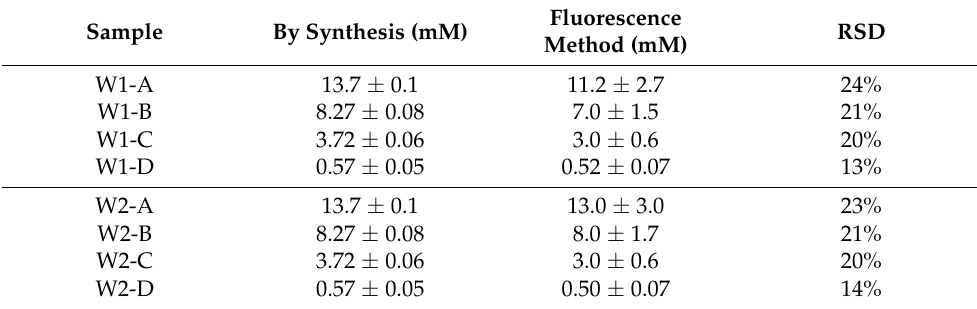
Table 4. Real water contaminated by